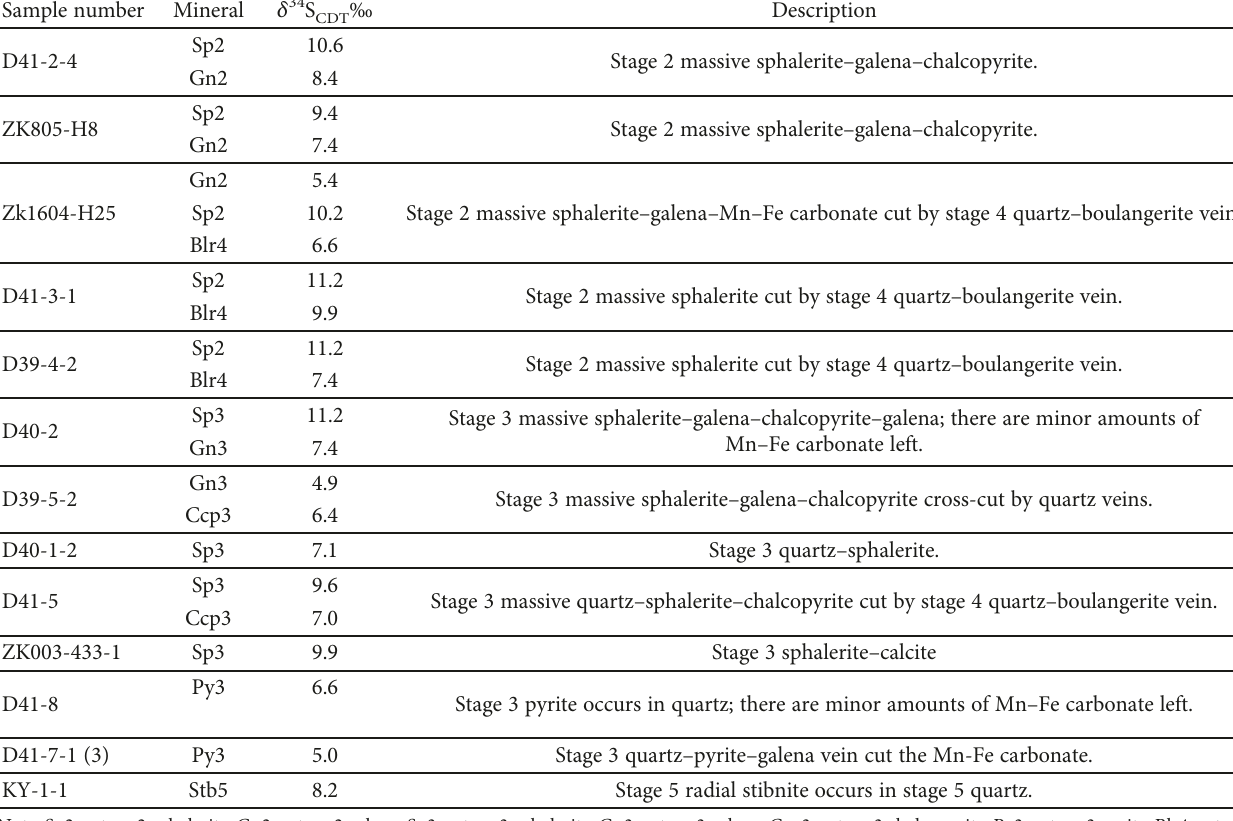
Table 4: The S isotopic data for sul fi des from the Keyue deposit.